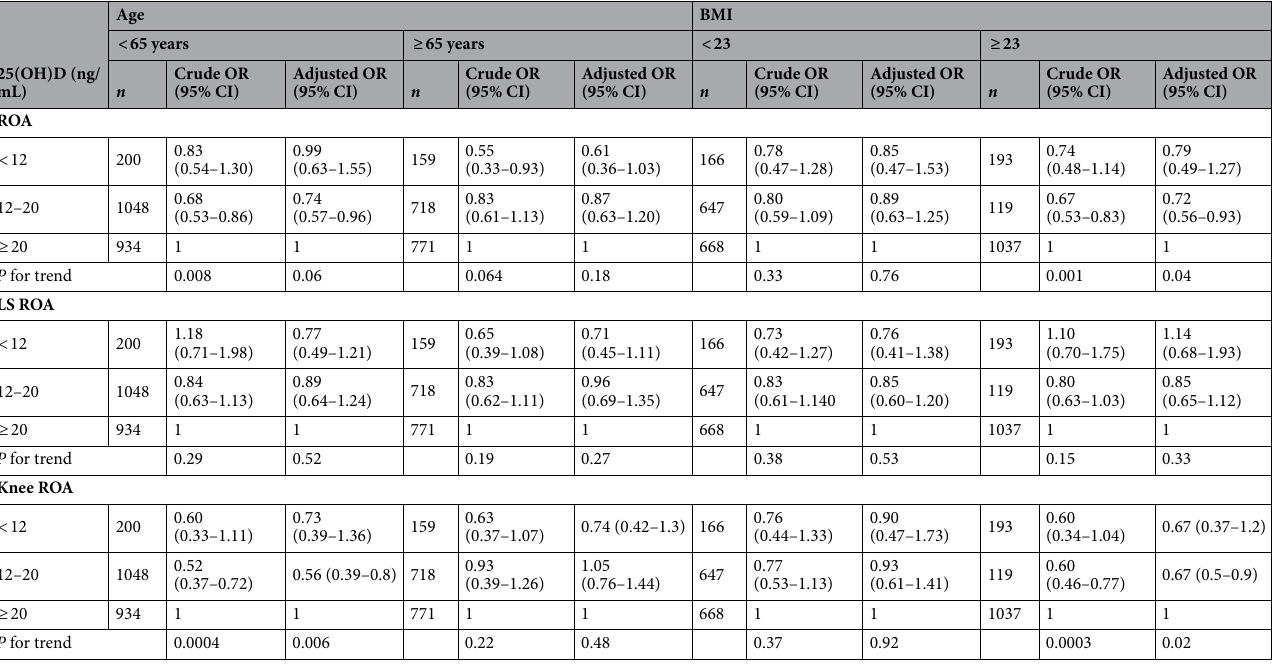
Table 2. Crude and adjusted ORs (95% CI) of ROA by 25(OH)D status in men 50 years and older from KNHANES 2010–2013 ( n = 3830) stratified by age or BMI. BMI was categorized as underweight/normal weight (< 23) and overweight/obese (≥ 23) according to the World Health Organization overweight and obesity criteria for Asians 49 . ROA indicates at least one incidence of ROA at the knee, lumbar spine, or hip confirmed by X-ray. Logistic regression was used for analyses. All models were adjusted for clustering and stratification. Adjusted models were adjusted for age, income, education level, longest job, physical activity, smoking status, alcohol consumption, BMI (when stratified by age), season of blood draw, and survey year. Weights were applied according to the guidelines of the KNHANES. BMI, body mass index; CI, confidence interval; KNHANES, Korea National Health and Nutrition Examination Survey; LS, lumbar spine; OR, odds ratio; ROA, radiologic osteoarthritis; 25(OH)D, 25-hydroxyvitamin D.